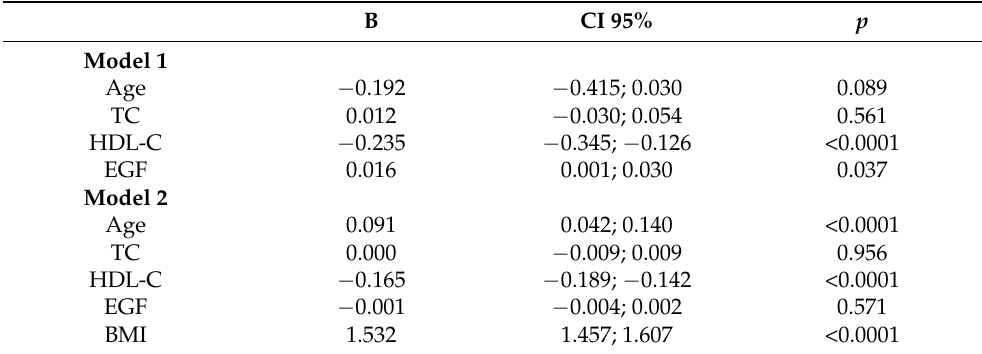
Table 4. Linear regression analyses exploring the association of EGF (Epidermal Growth Factor) with METS-IR, controlling for multiple confounding factors in women ( n = 82). B CI 95%